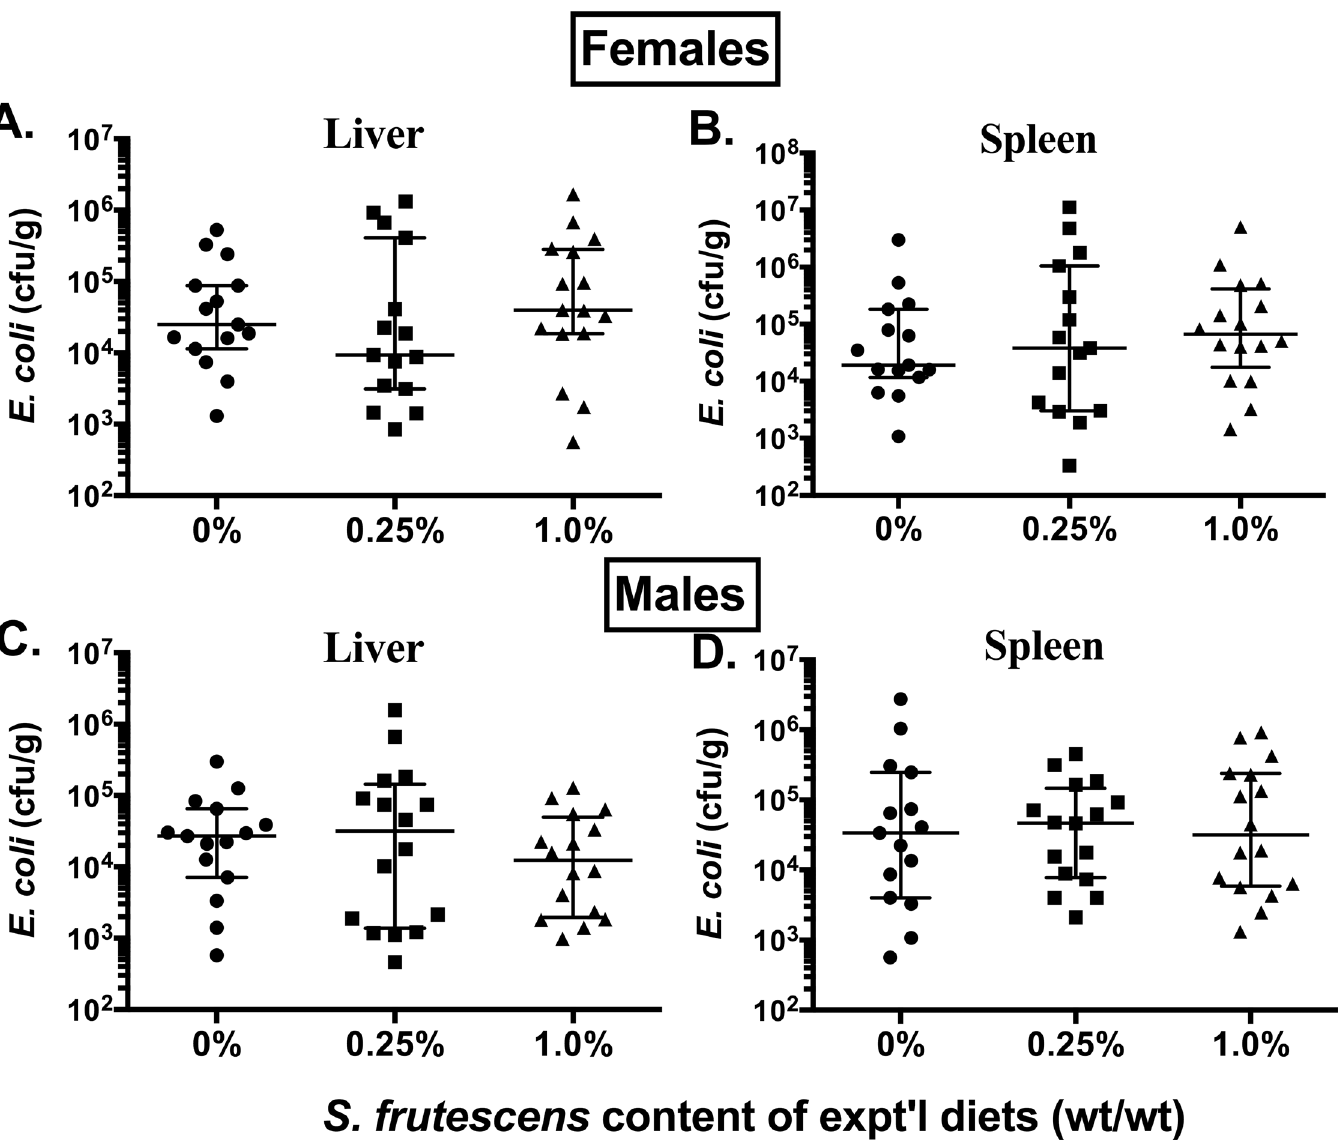
Fig 2. Impact of S . frutescens Consumption on Host Clearance of an Experimental Infection with E . coli . Weanling female and male C57Bl/6 mice were randomly assigned to one of three treatment groups: 0, 0.25, or 1.0% (wt/wt) S . frutescens in an AIN93G-type diet. After consuming diets for ~4 wks, all mice were injected intraperitoneally with ~10 8 colony-forming units ( cfu ) of E . coli (K-12 strain) in 1 mL of sterile PBS. Liver and spleen samples were harvested three days after challenge and colony-forming units ( cfu ) were determined by a fluorescence-based microplate assay of tissue homogenates. Each symbol represents the data from a single mouse with the median and intra-quartile range